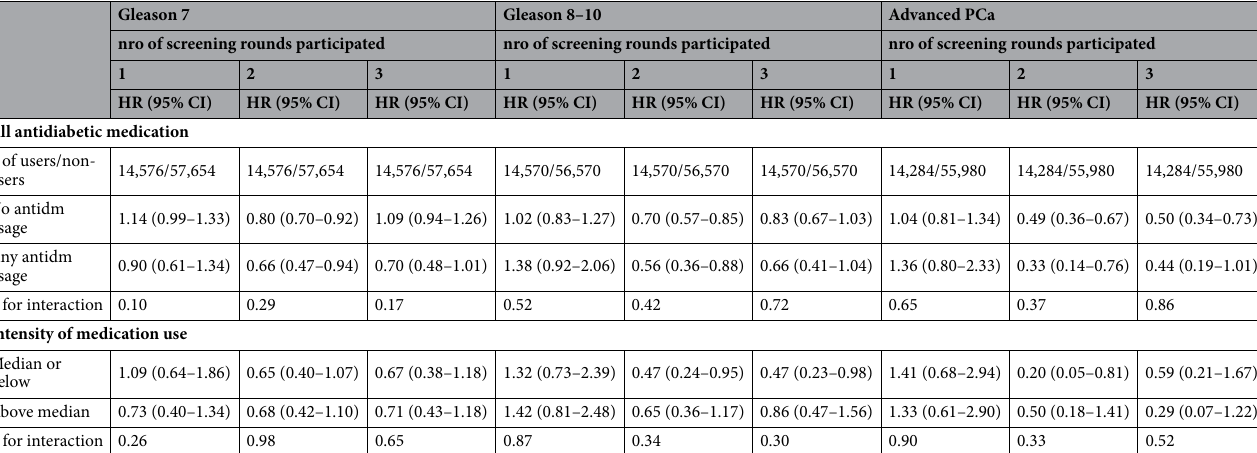
Table 4. Effect of PSA-based screening on incidence on clinically significant prostate cancer as defined by Gleason score and TNM stage, stratified by antidiabetic medication use. Study population of 78,615 men from the Finnish Randomized Study of Screening for Prostate Cancer.